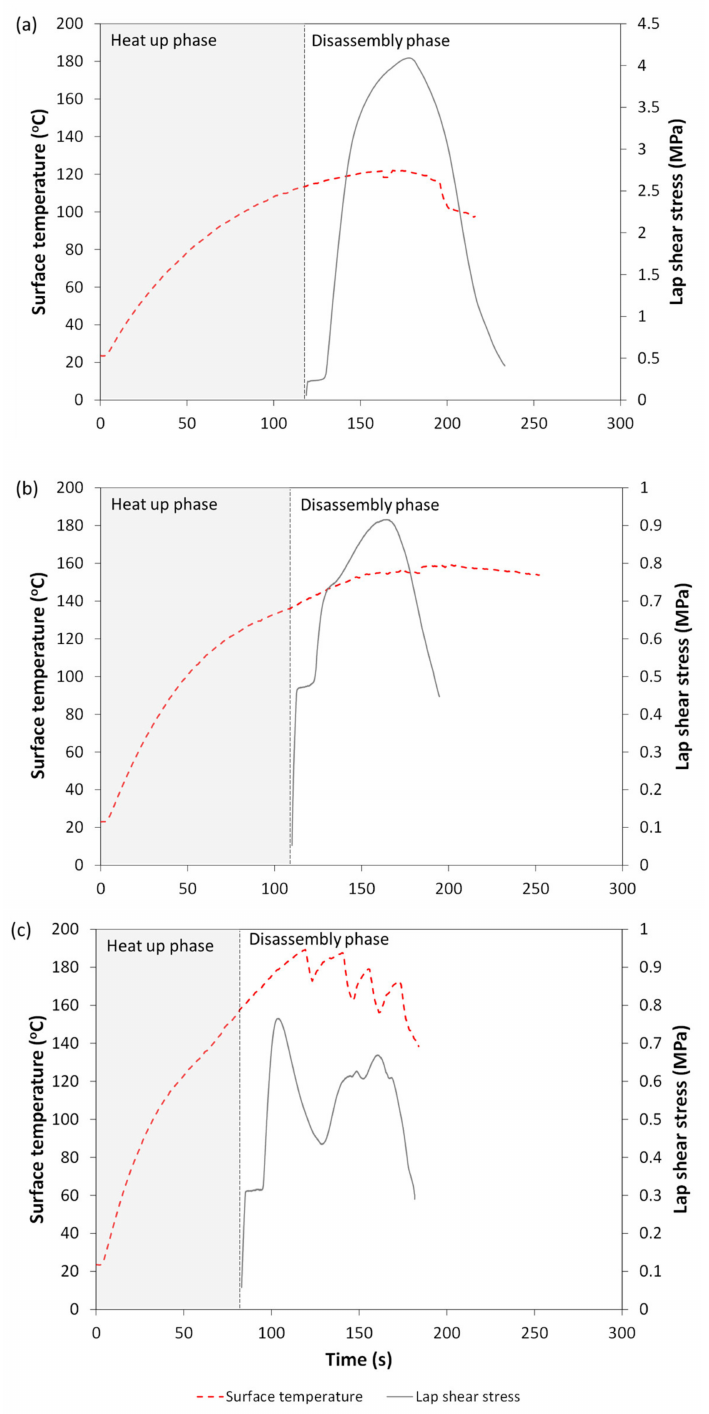
Figure 10. Representative lap shear stress curves (solid lines) of GF/PP welded joints during disas- sembly procedure with interface containing ( a ) 15 wt.% MWCNT at adherend’s surface temperatures of 110 ◦ C; ( b ) 20 wt.% MWCNT at adherend’s surface temperatures of 130 ◦ C; and ( c ) 25 wt.% MWCNT at adherend’s surface temperatures of 150 ◦ C. Corresponding surface temperature curves are shown as dashed